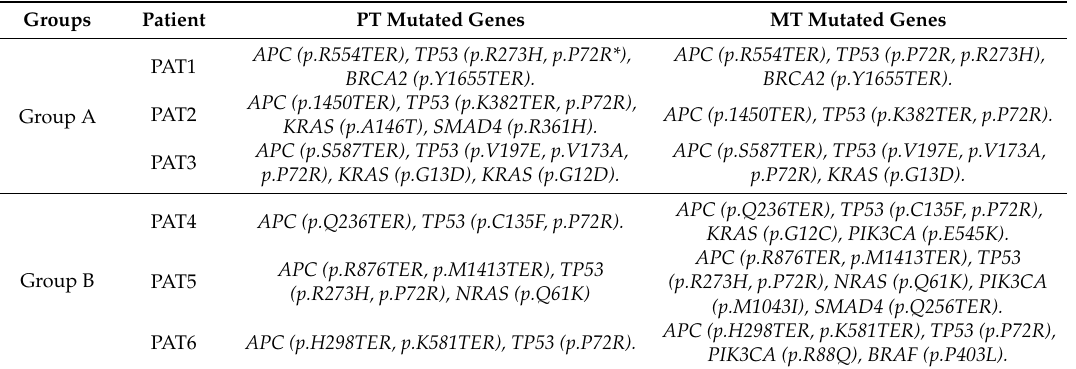
Table 3. Summary of patient-by-patient CRC key driver mutated genes (Tier1 / 2 / 3 according to four-tiered structure of AMP / ACMG